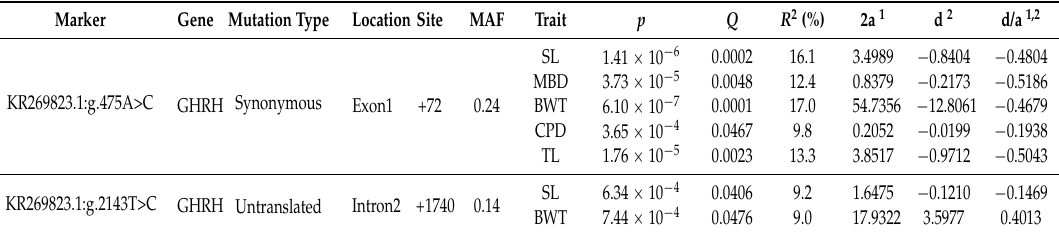
Table 3. Summary of molecular markers identified via association mapping.